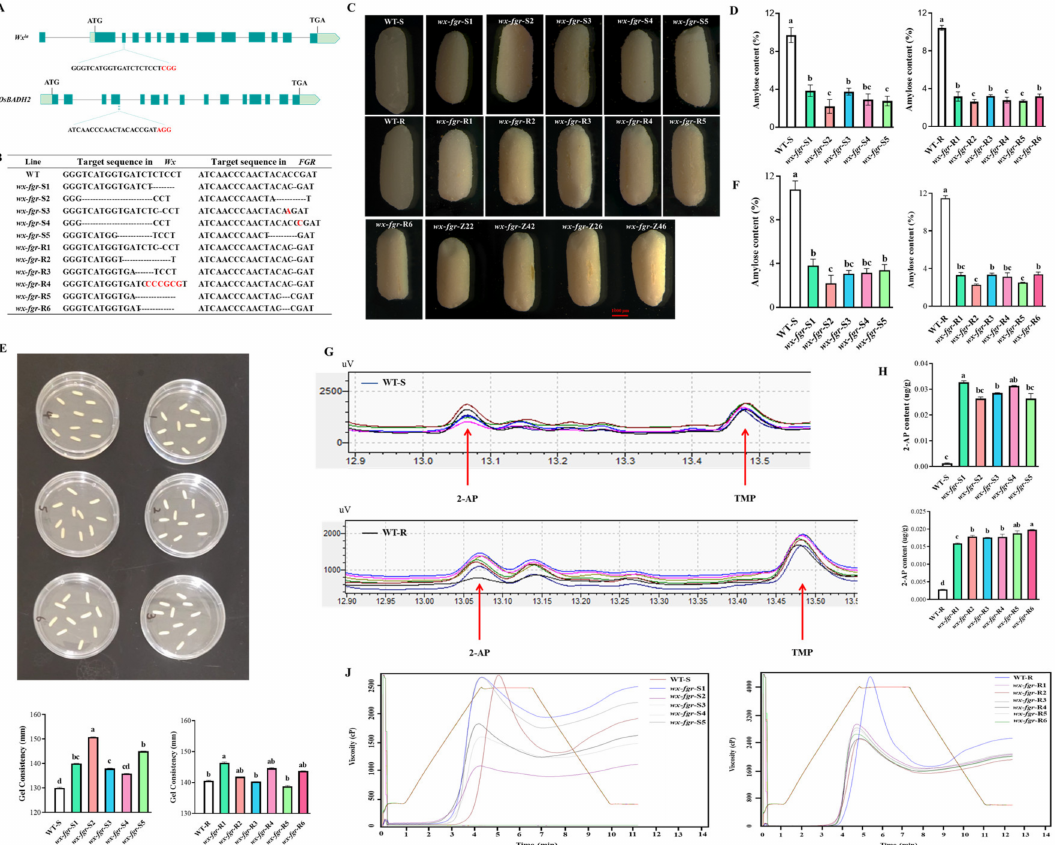
Figure 1. Improvement of rice grain quality by editing of the Wx la and OsBADH2 using CRISPR/Cas9. ( A ) Schematic diagram of the targeted sites in Wx and OsBADH2 . The protospacer-adjacent motifs (PAMs) are shown in red. ( B ) Mutations in the edited T 3 lines. Inserted bases are marked in red, and missing bases are indicated by short dashed lines. ( C ) Morphology of milled rice from ZN1S, ZN1307 and the F 1 hybrid ZN1S mutants × ZN1307 mutants. WT-S represents the wild type of sterile line ZN1S and WT-R represents the wild type of restorer line ZN1307. Scale bars, 1000 µ m. ( D ) The amylose contents determined by iodine colorimetry of ZN1S, ZN1307 and their T 3 generation homozygous mutant lines. ( E ) Sensory evaluation of the aroma of ZN1S, ZN1307 and their mutants by potassium hydroxide method. ( F ) The grain amylose contents determined by iodine colorimetry of ZN1S, ZN1307 and their T 4 generation homozygous mutant lines. ( G ) Total ion chromatograms (TIC) of 2-AP and TMP in the grains of ZN1S, ZN1307 and their T 4 generation homozygous mutant lines. ( H ) 2-AP content in grains of ZN1S, ZN1307 and their T 4 generation homozygous mutant lines. 2, 4, 6-trimethyl pyridine (TMP) was used as the internal standard. ( I ) Gel consistency. ( J ) Rapid visco analysis profiles of grain starches of ZN1S, ZN1307 and their T 4 generation homozygous mutant lines. cP (centi Poise), viscosity unit. Error bars are means ± SD ( n = 3). Samples without the same letter show significant difference by Duncan’s test ( p <